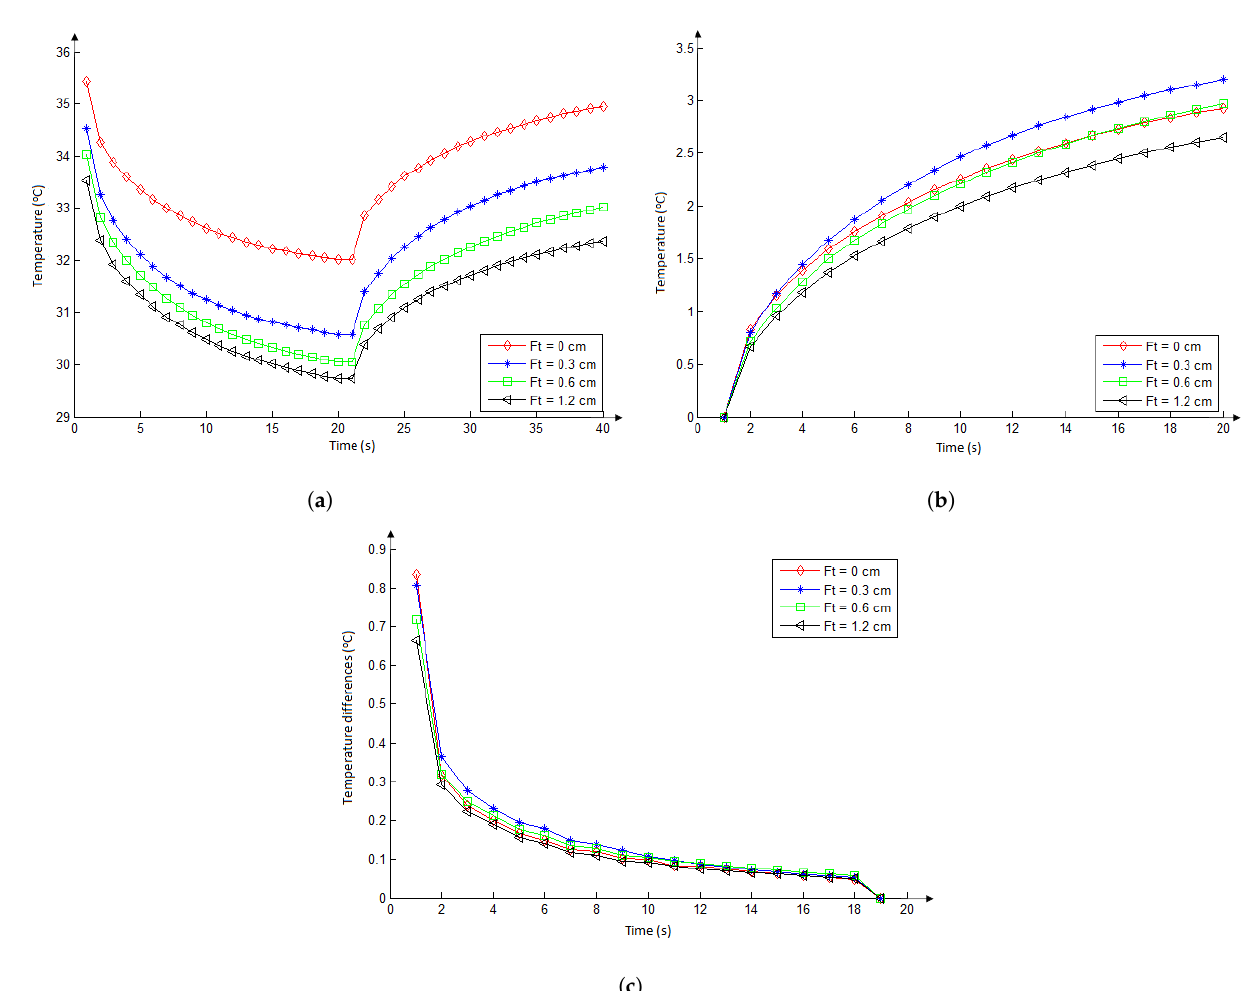
Figure 10. Influence of fat tissue thickness on the skin temperature just in front of the nodule (the red point in Figure 7) over the time of the exam of the simulated protocol ( a ). Temperatures at the same position on the natural reheating stage ( b ) but considering each curve starting with the same temperature for better comparison. The rate of superficial temperature at same point ( c ). (Note the peculiar behavior of the zero value differing from the tendency to zero of 0.6 and 0.3 cm in ( b ) and ( c